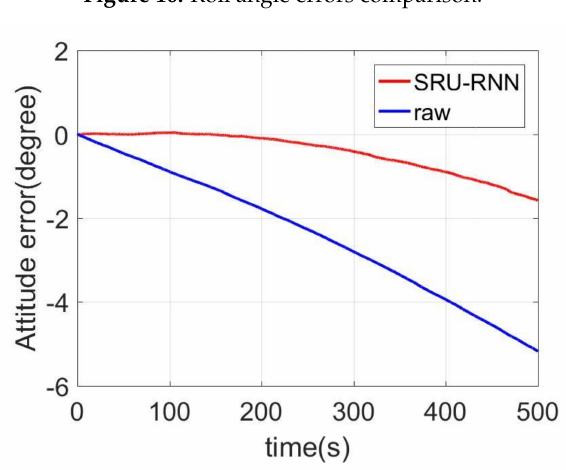
Figure 17. Yaw angle errors